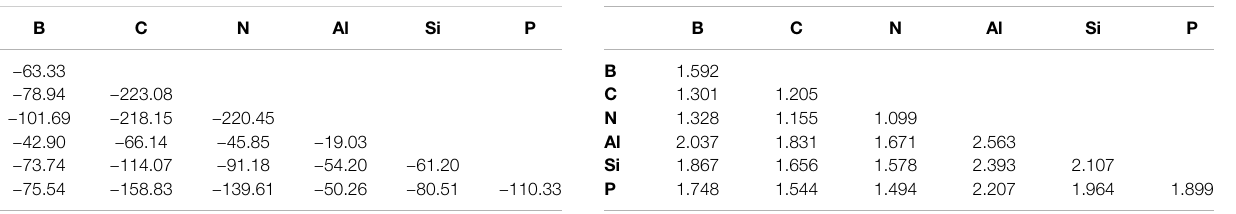
TABLE 3 | X ≡ Y Bond energies for “ Triple-Bonded ” molecules (kcal/mol). TABLE 4 | X ≡ Y Bond lengths